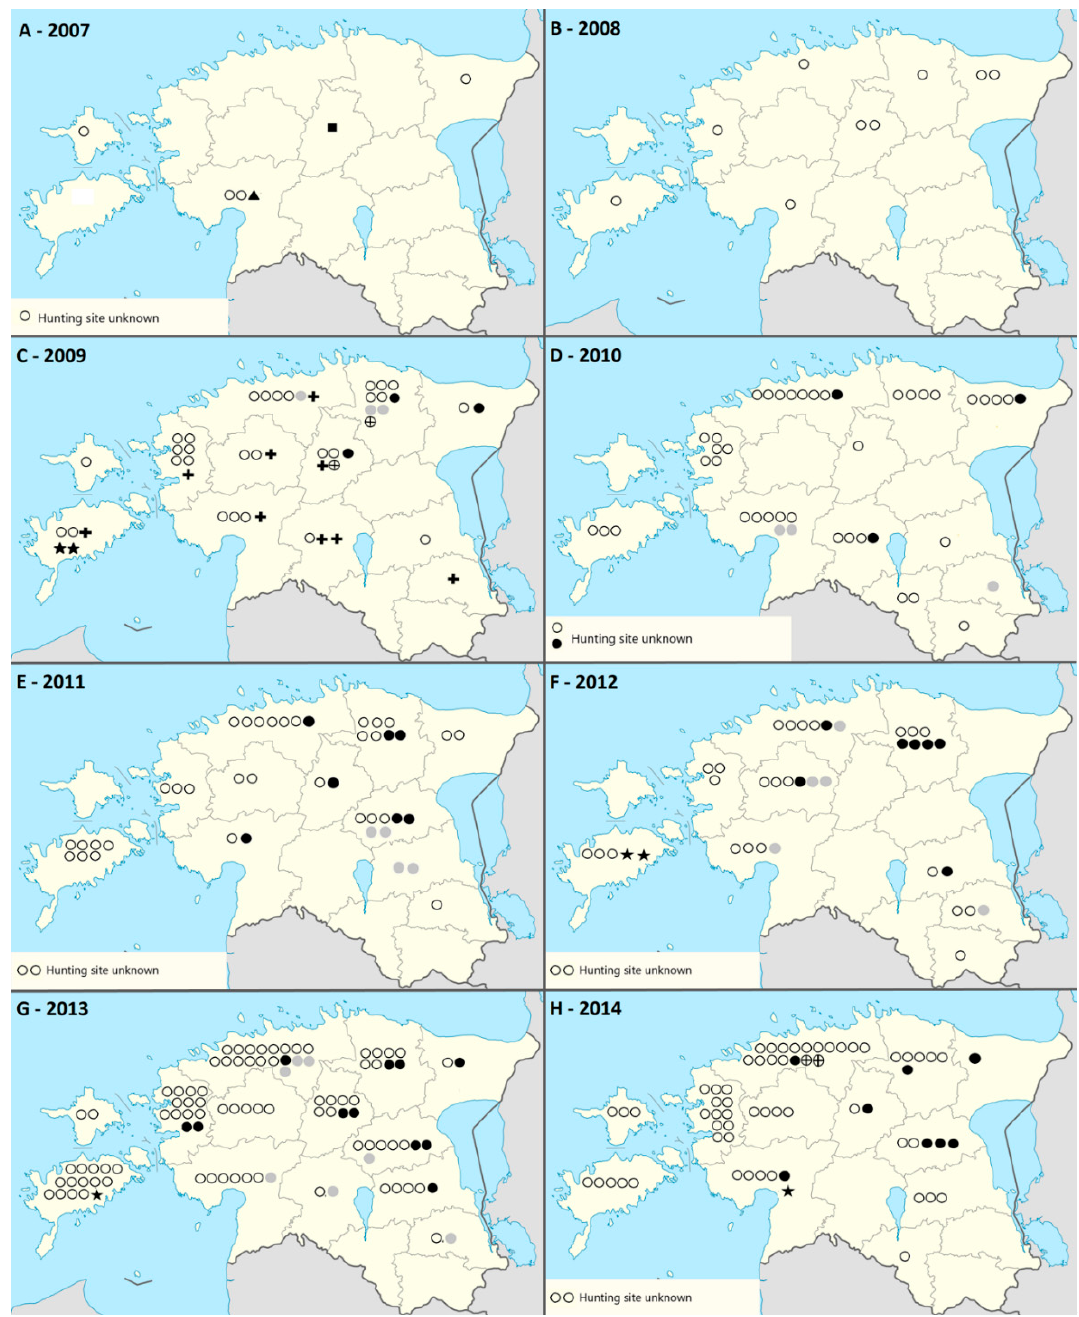
Figure 2. Trichinella species distribution in the tested animals that were positive and Trichinella species identification was successful, 2007–2014 (A–H, respectively), Estonia. T. britovi —ring, T. nativa —black dot, T. pseudospiralis —star; T. spiralis —cross, T. britovi and T. nativa —grey dot, T. britovi and T. spiralis —ring with cross.